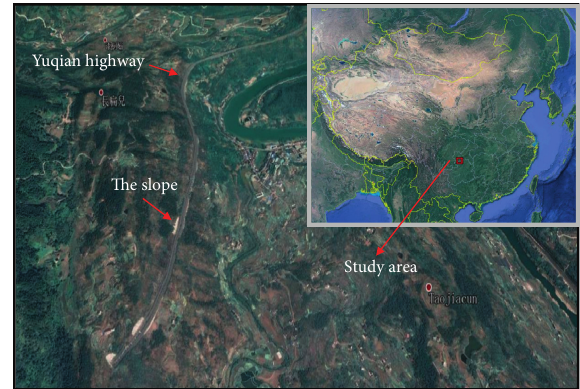
Figure 3: The geographical location of the study area (Google Earth,